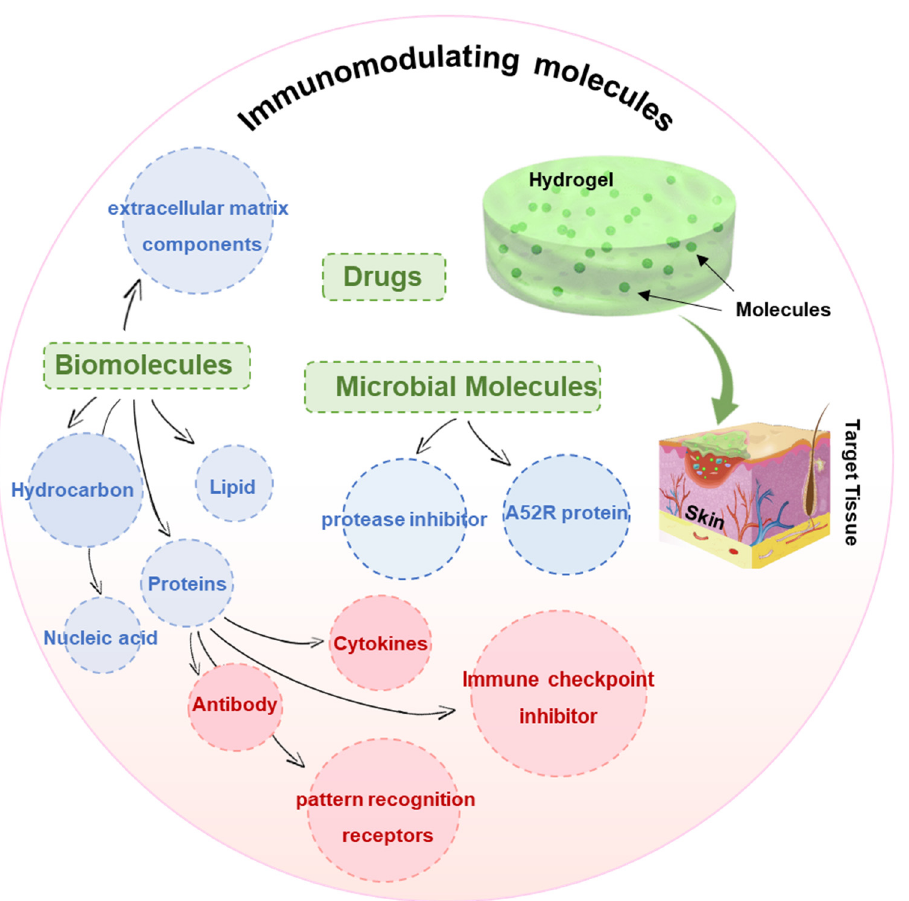
Figure 4. Scheme of different types of immunomodulating molecules.